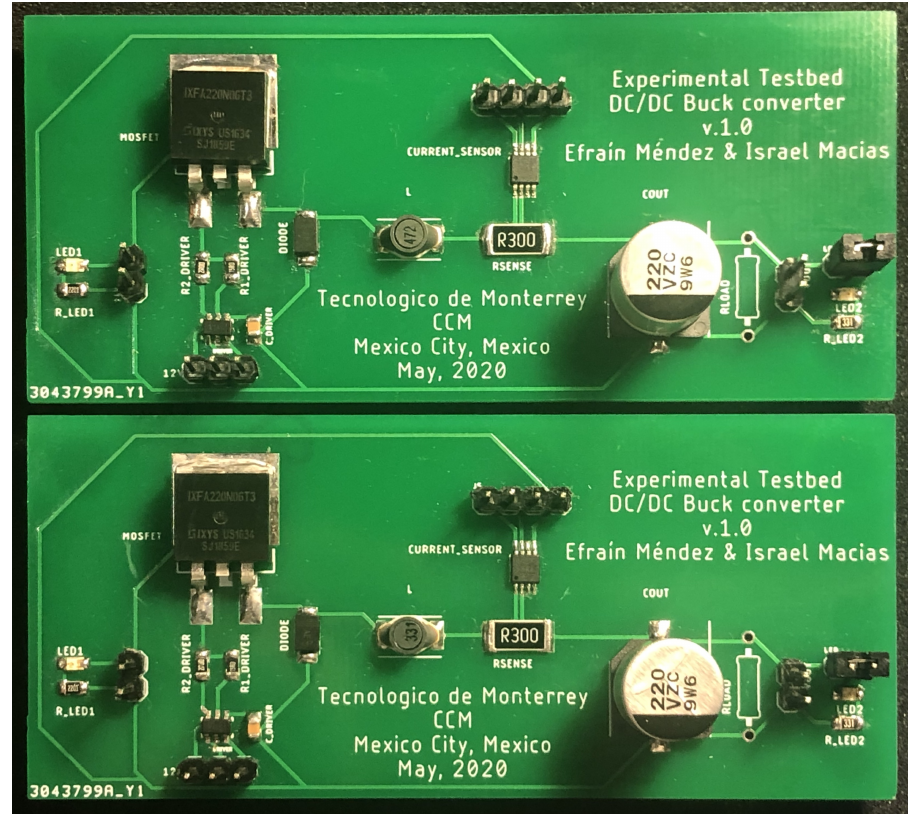
Figure 16. Manufactured PCBs for the experimental